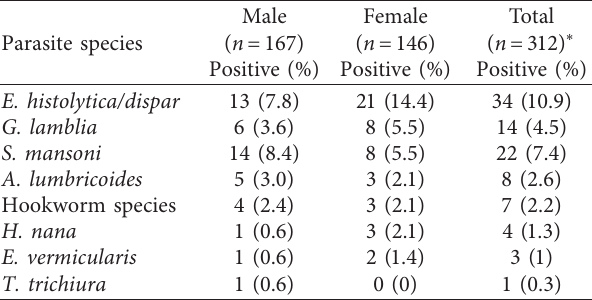
Table 1: Sociodemographic characteristics among schoolchildren in the two involved schools in Rama town, Northern